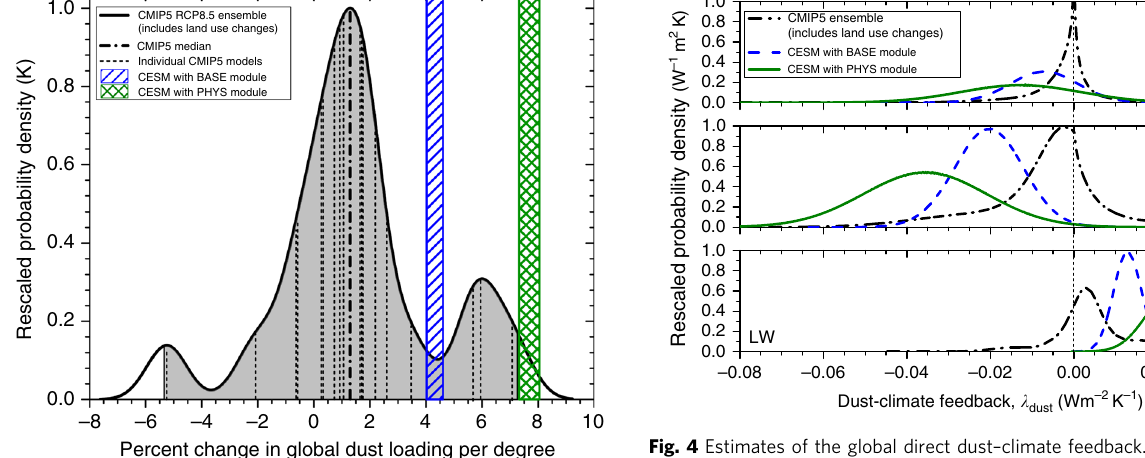
Fig. 4 Estimates of the global direct dust – climate feedback. Results are calculated from the ensemble of CMIP5 simulations (black dash-dotted lines), and from CESM simulations with the BASE (blue dashed lines) and PHYS (green solid lines) emission modules. The total feedback (top) could equal a substantial fraction of the climate system ’ s total direct aerosol feedbacks 29 . The direct dust – climate feedback ( λ dust ) consists of somewhat larger opposing contributions from cooling SW interactions (middle)